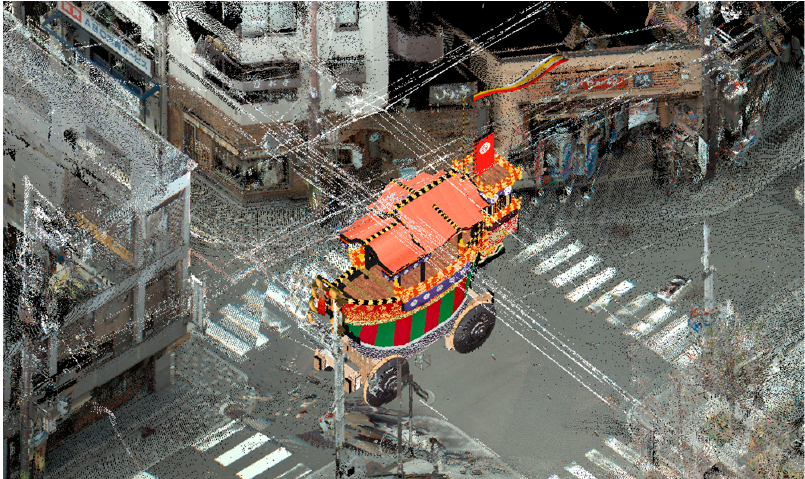
Figure 10. Point cloud of the Ofune-hoko float that is placed in the scene of Figure 6.